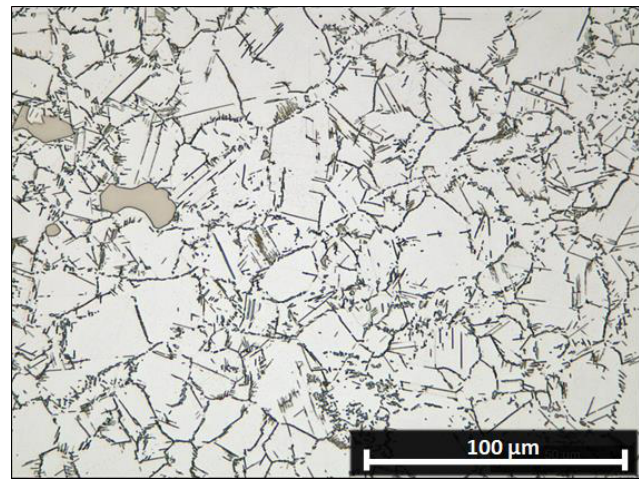
Figure 1. Micrograph of the alloy 718 test piece material. Table 1. Chemical composition from material certificate of the alloy 718 billet, in weight-%, used for test specimens.